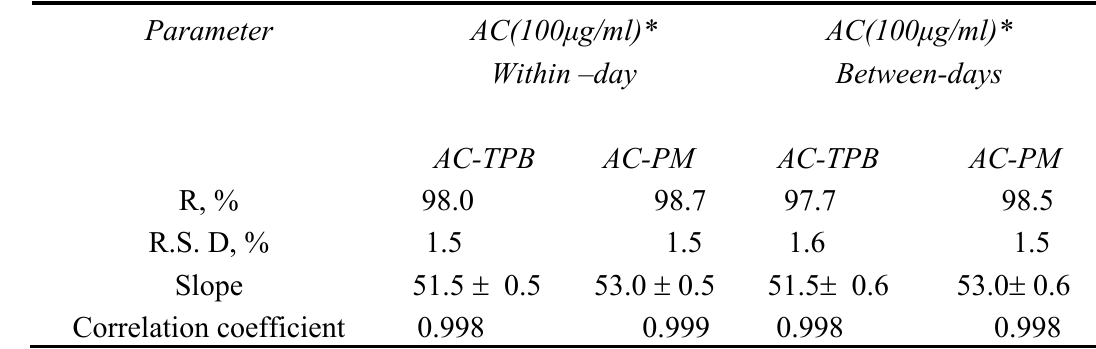
Table 2. Day to day reproducibility of the proposed